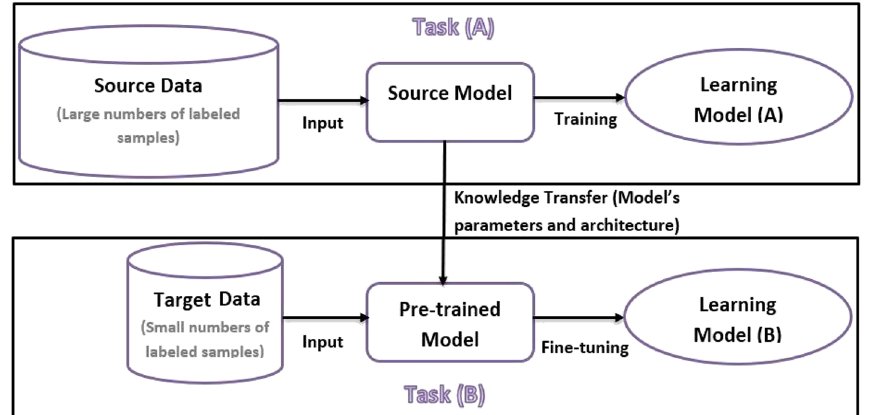
Figure 1. Transfer learning methodology creates high-performing learners by extracting knowledge learned from previous tasks and applying it to new related low-data